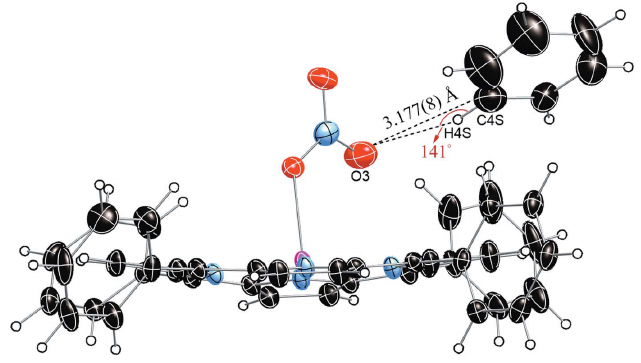
Figure 5 A view of the molecular packing of the title compound in the crystal structure, as seen in a projection along [100]. H atoms have been omitted for clarity.